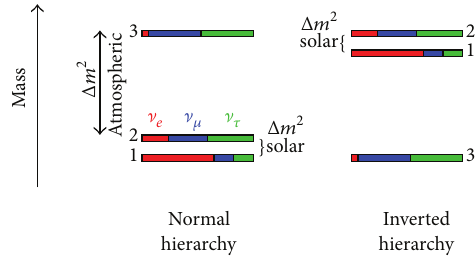
Figure 1: The sign of Δ𝑚 2 31 ≡ 𝑚 2 3 −𝑚 2 1 is unknown. The hierarchy of the neutrino mass spectrum can be normal or